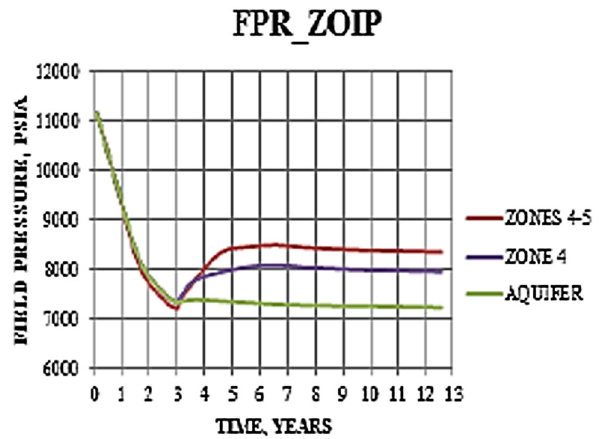
Fig. 17 Plot of field pressure versus time for different ZoIP scenarios for the five-spot waterflood